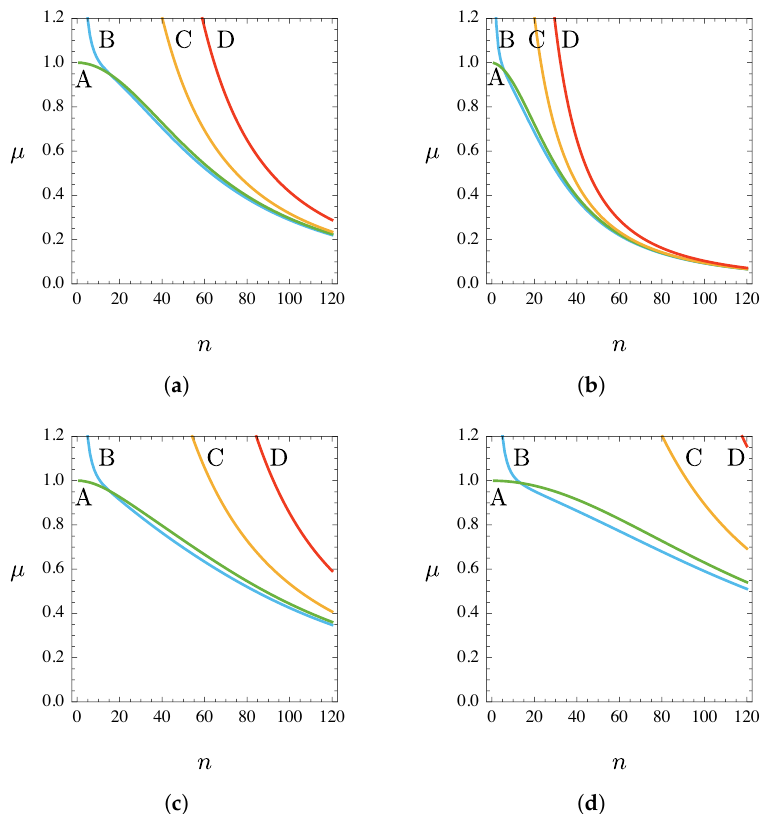
Figure 3. Non-dimensional critical load µ vs. the number of cells n , for the case study I and for different boundary conditions: ( a ) Hinge–roller (H-R); ( b ) clamp–free (C-F); ( c ) clamp–roller (C-R); ( d ) clamp–slider (C-S). Green curve (A): Timoshenko model; blue curve (B): Finite-element (FE) solution; yellow (C) and red (D) curves: Timoshenko and Euler–Bernoulli models without constitutive geometric